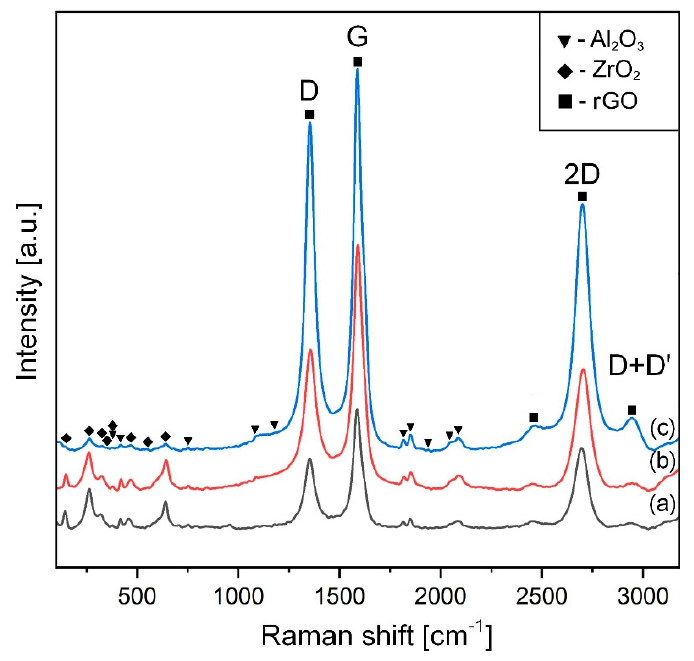
Figure 4. Raman spectra of sintered composites containing 0 wt.% GO (a); 0.28 wt.% GO (b); 0.52 wt.% GO (c) and 6.1 wt.% GO (d).